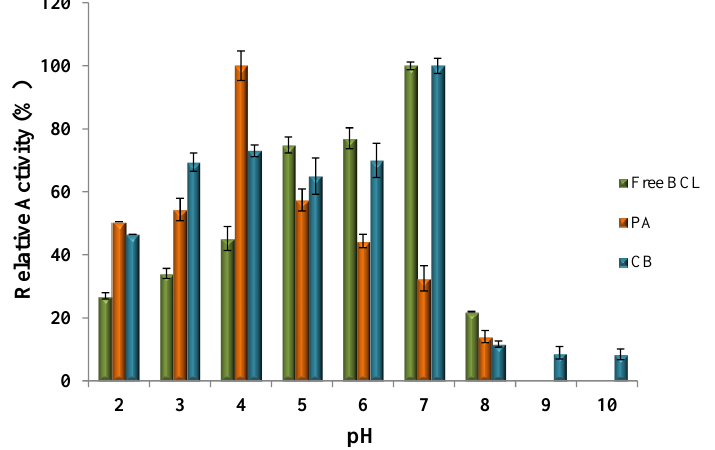
Figure 3. pH effect on the activity of free BCL and immobilized by physical adsorption (PA), and covalent binding (CB).